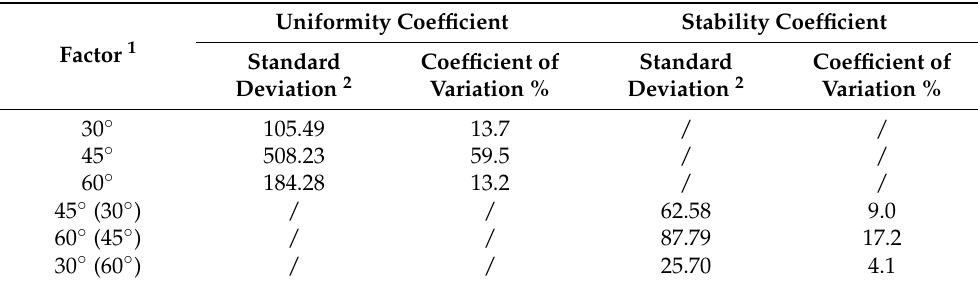
Table 2. Coefficient of uniformity and stability of covering soil at different